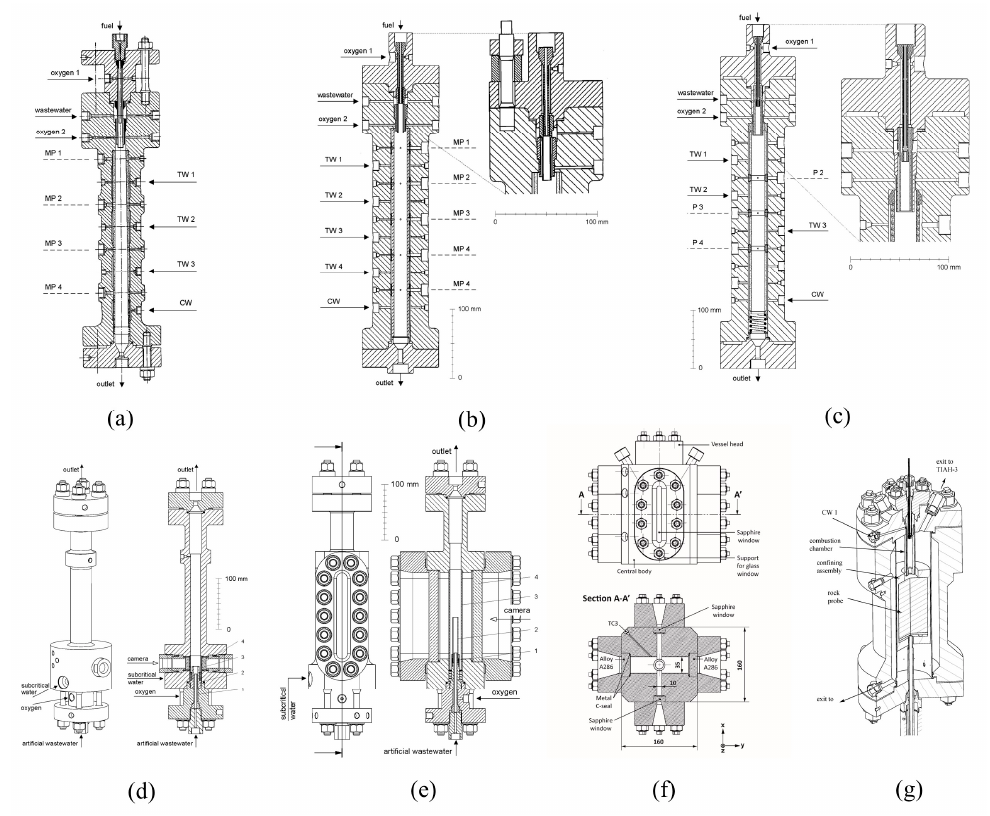
Figure 3. TWR and WCHB from ETH ( a ) The first version of TWR (adapted from [72]); ( b ) The modified version of TWR (adapted from [72]); ( c ) The final version of TWR (adapted from [72]); ( d ) WCHB-1 (adapted from [27]); ( e ) WCHB-2 (adapted from [27]); ( f ) WCHB-3 (adapted from [27]); ( g ) WCHB-4 (adapted from [22,23]).